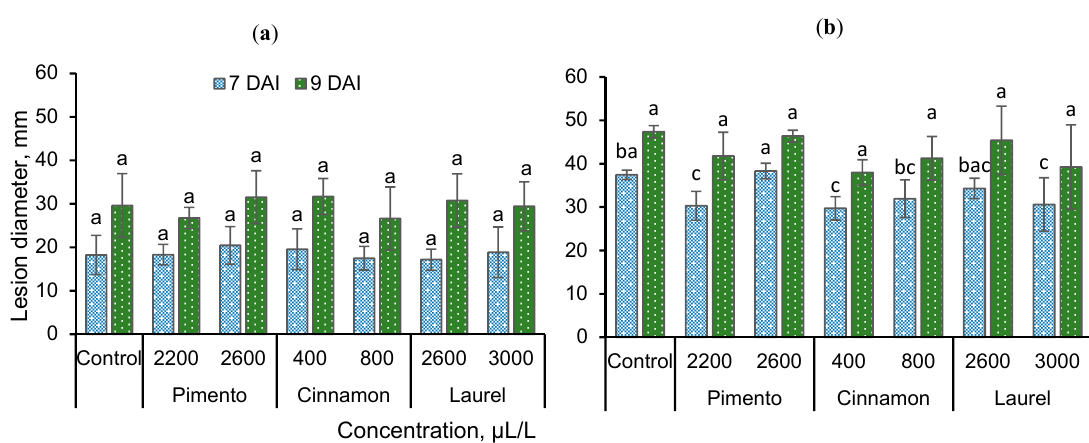
Figure 2. Lesion diameter (mm) on apple fruits after treatment with di ff erent concentrations of extracts: ( a ) rot caused by strawberry Botrytis cinerea ; ( b ) rot caused by apple B. cinerea . DAI—days after inoculation; the same letters indicate no significant di ff erences between treatments according to Duncan’s multiple range test ( p < 0.05) at 2, 4, and 7 DAI. Table 1. Mycelial growth inhibition of B. cinerea on apples by di ff erent extracts compared to the control at 7 days after inoculation.